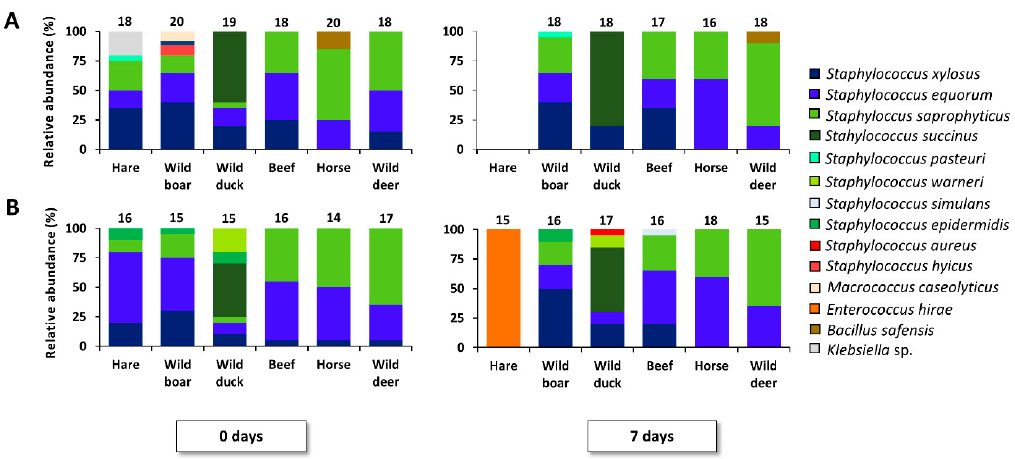
Figure 3. Course of bacterial species isolated from MSA during fermentation of less conventional meat types, including two replicates ( A , B ) at 23 ◦ C for 7 days. The number of isolates for identification is mentioned above each bar. The bacterial species diversity is displayed as relative abundances, calculated based on the number of isolates (N) obtained per time point (0 and 7 days of meat fermentation).